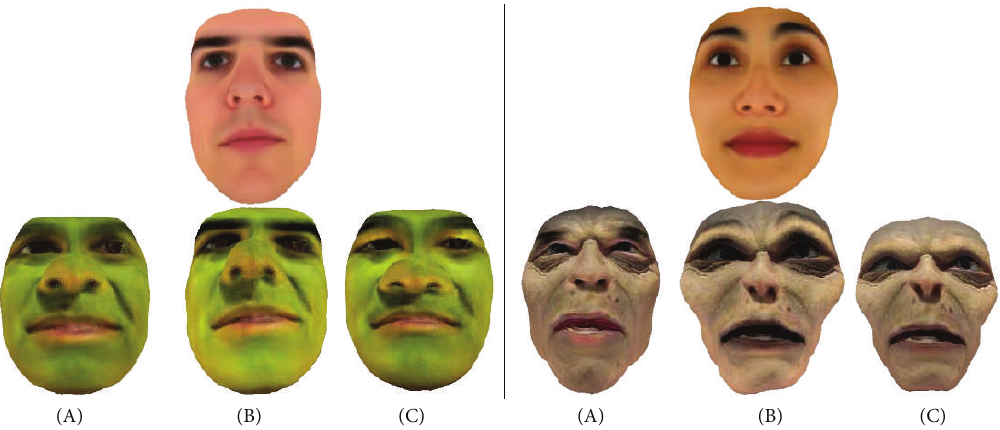
Figure 11: Questionnaire examples. (Left): the questionnaire that has the highest recognition rate (94.1 percent) and (Right) the questionnaire that has the lowest recognition rate (58.8 percent). The correct answers of both are